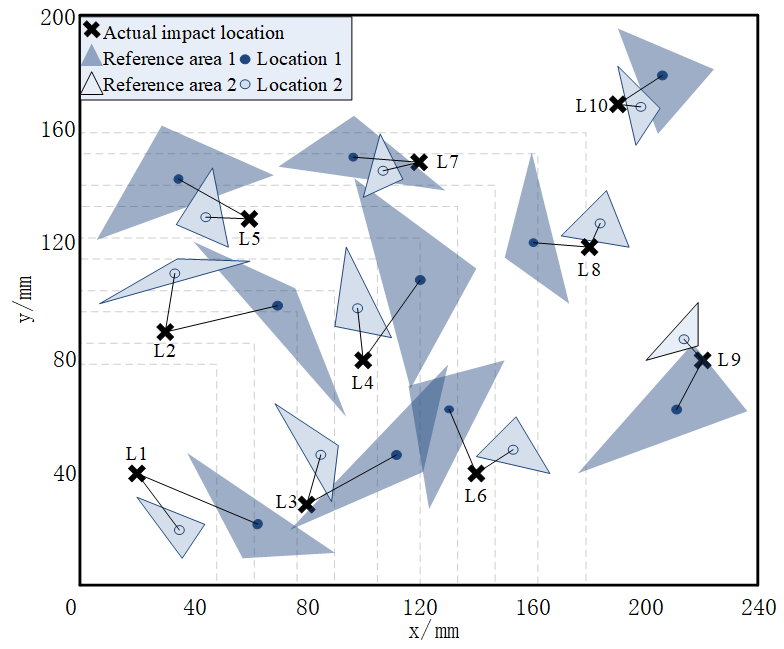
Figure 14. Verification experimental results of impact localization.